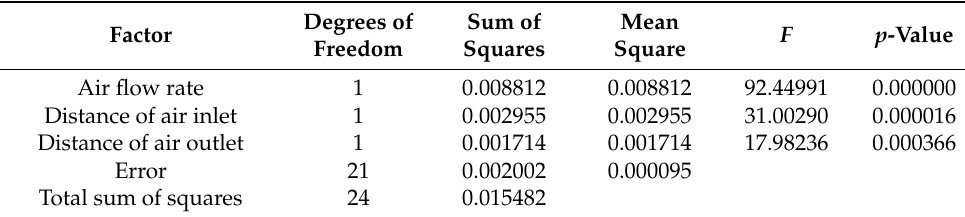
Table 9. Results of the analysis of variance applied to the air velocity in the reaction cell with lateral air inlet and outlet geometry. Degrees of Sum of Mean F p -Value Factor Freedom Squares Square Air flow rate